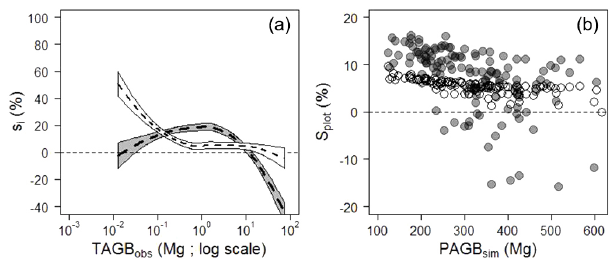
Figure 5. Panel (a) : relative individual residuals ( s i , in %) obtained with the reference biomass allometric model m 0 (grey background) and with our model m 2 including a crown mass proxy (white back- ground). Thick dashed lines represent fits of local regressions (loess function; span: 1) bounded by standard errors. Panel (b) : propaga- tion of individual residual errors of m 0 (solid grey circles) and m 2 (empty circles) to the plot